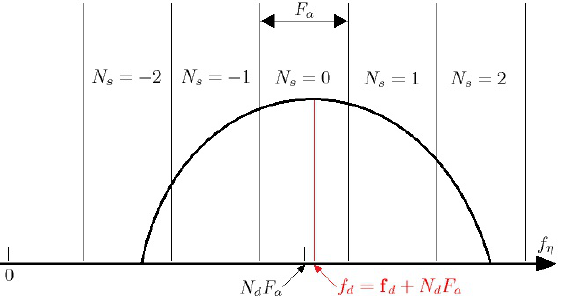
Figure 1. Schematic of original azimuth spectrum before wrapping due to ASA and